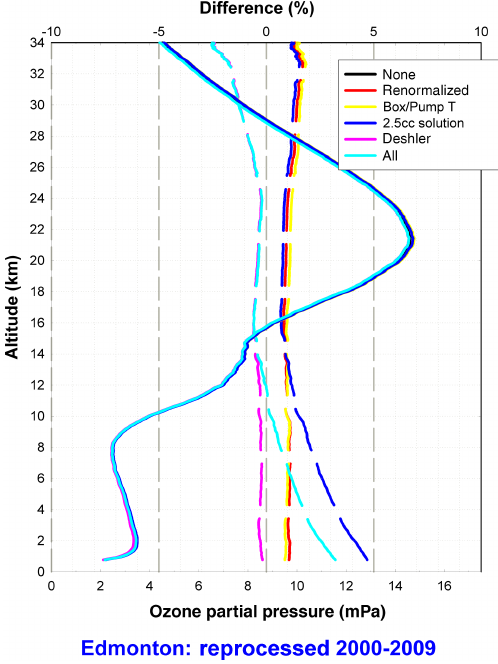
Figure 4. As Fig. 1 but for the 2000s. “Deshler” shows the average change introduced by the correction for the use of standard 1% KI solution in ENSCI sondes (Sect. 2.5). Overall changes to the record are